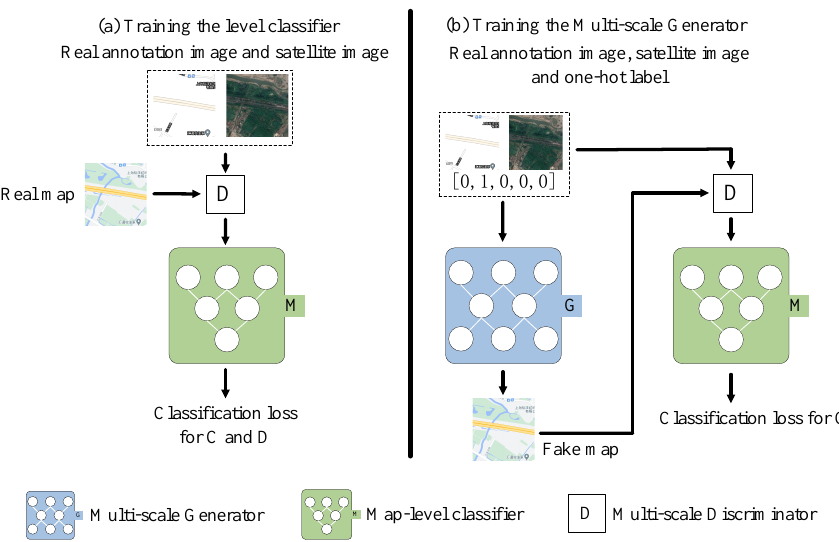
Figure 7. The training procedure of the map-level classifier . G represents the multi-scale generator, M represents the map-level classifier, and D represents the multi-scale discriminator. ( a ) The real image goes through D and then into M to calculate the classification loss and optimize the classifier and the multi-scale discriminator D i . ( b ) G generates a map based on the input RS image, annotation image and level label. Then, M calculates the classification loss of the generator and optimizes the multi-scale